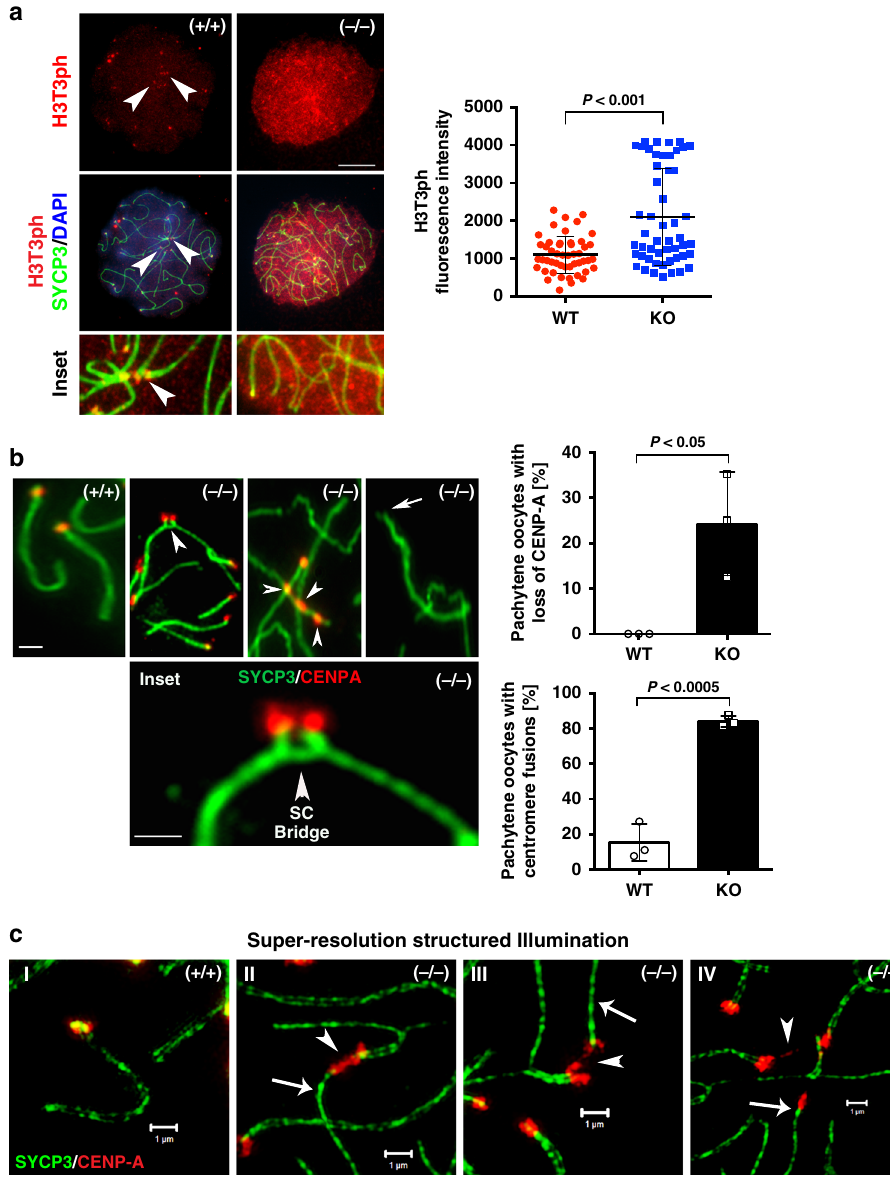
Fig. 2 LSH ( − / − ) oocytes exhibit increased H3T3 phosphorylation and kinetochore fusions between paired bivalents and asynapsed chromosomes. a Histone H3 phosphorylation at threonine 3 (H3T3ph; red) exhibits a kinetochore localization (arrowheads) in fully synapsed bivalents of wild-type pachytene oocytes ( n = 49). By contrast, LSH − / − oocytes ( n = 51) exhibit a signi fi cant increase in the levels of H3T3ph throughout the nucleoplasm and abnormal chromosome synapsis. Oocytes were exposed to TX-100 detergent extraction before immunochemistry. Data represent the mean ± SD